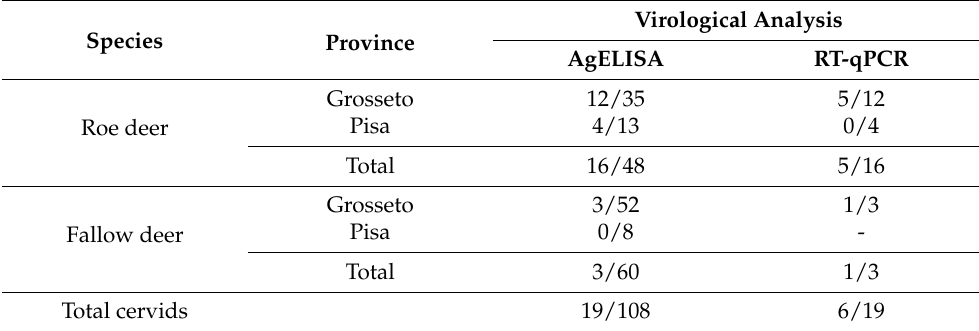
Table 4. Virological analysis (immunoenzymatic screening and RT-PCR) conducted on liver samples from the 48 roe deer and the 60 fallow deer examined, divided by province